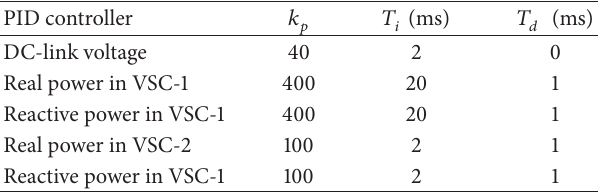
Table 2: The parameters of PID controller in BTB VSC-HVDC.